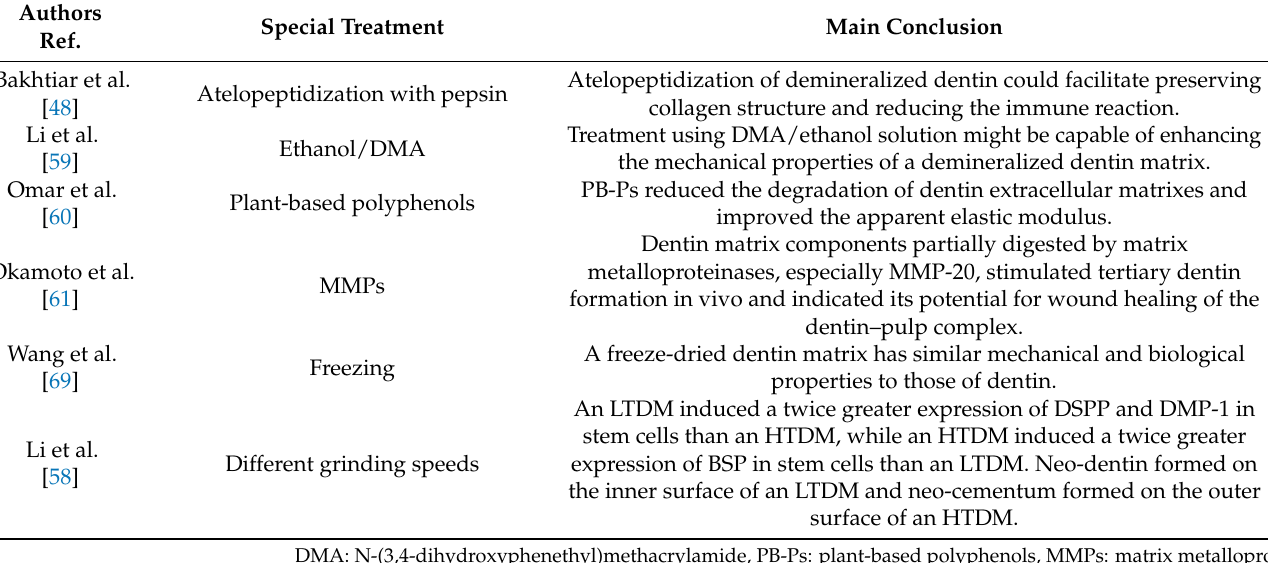
Figure 3. Basic procedure to obtain a treated dentin matrix. Table 3. Special treatments of treated dentin matrixes during the preparation procedure.